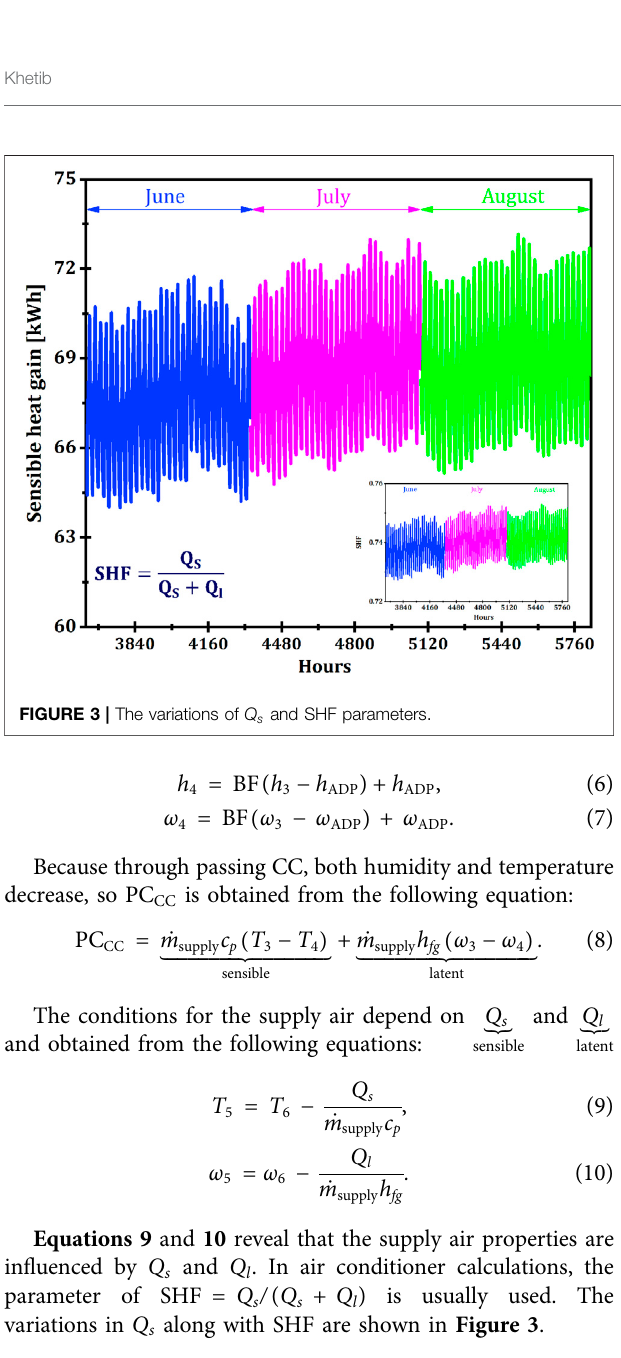
FIGURE 5 | Incident